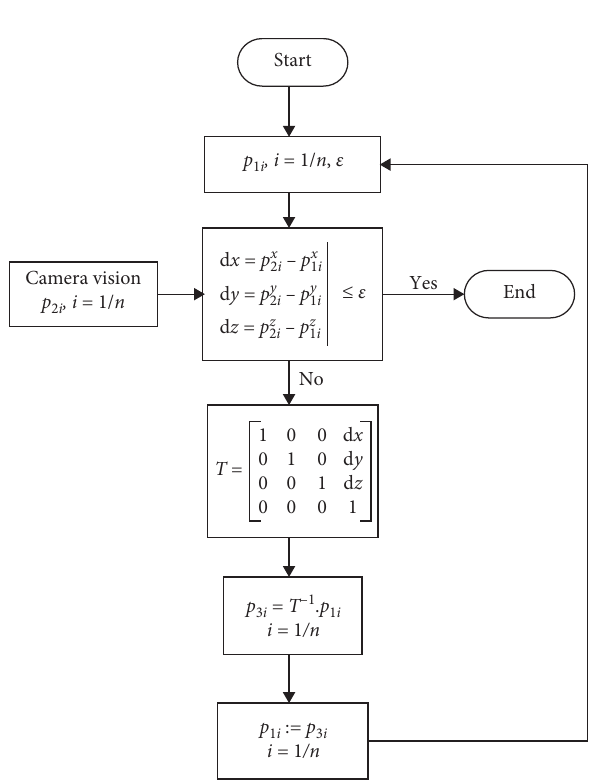
Figure 2: Principle of alternative trajectory formation.